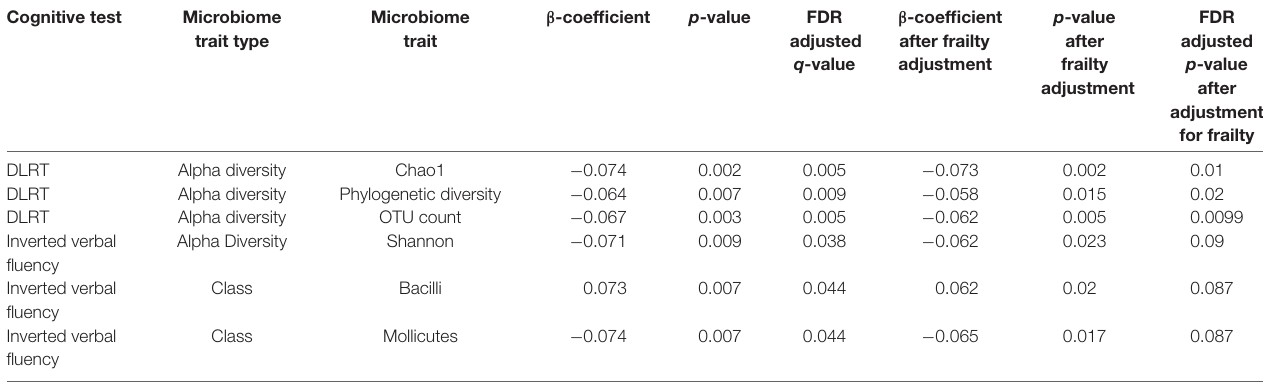
TABLE 2 | Significant associations observed between cognitive measures and the gut microbiome.